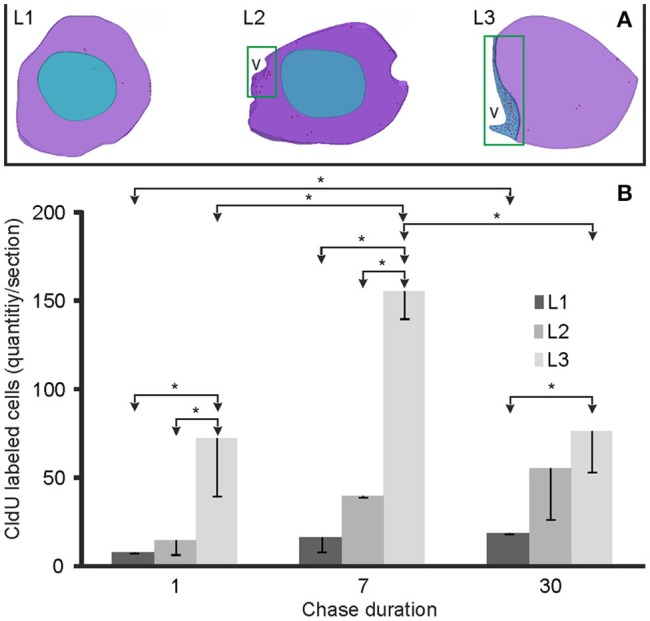
Spatial-temporal distribution and quantification of proliferating and derived cells within the rostral telencephalon. (A) The location of proliferating cells is represented by red dots in the 3D reconstructions of rostral (L1) and caudal (L2) olfactory bulb and rostral subpallium (L3). Proliferation zones were located at the ventricular lining indicated by green rectangles in L2 and L3. (B) Bar plots of the amount of labeled cells per section at the three levels studied (L1–L3) following 1 (N = 3), 7 (N = 2), and 30 (N = 3) days after the administration of a pulse of CldU. Values are expressed as the mean and standard deviation of the total amount of labeled cells per section. * <0.05, One-way ANOVA.